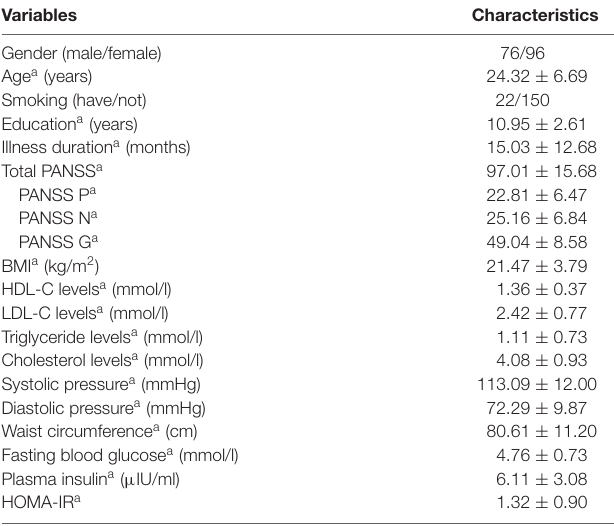
TABLE 1 | Demographic and clinical characteristics and metabolic parameters of the total number of patients ( n =